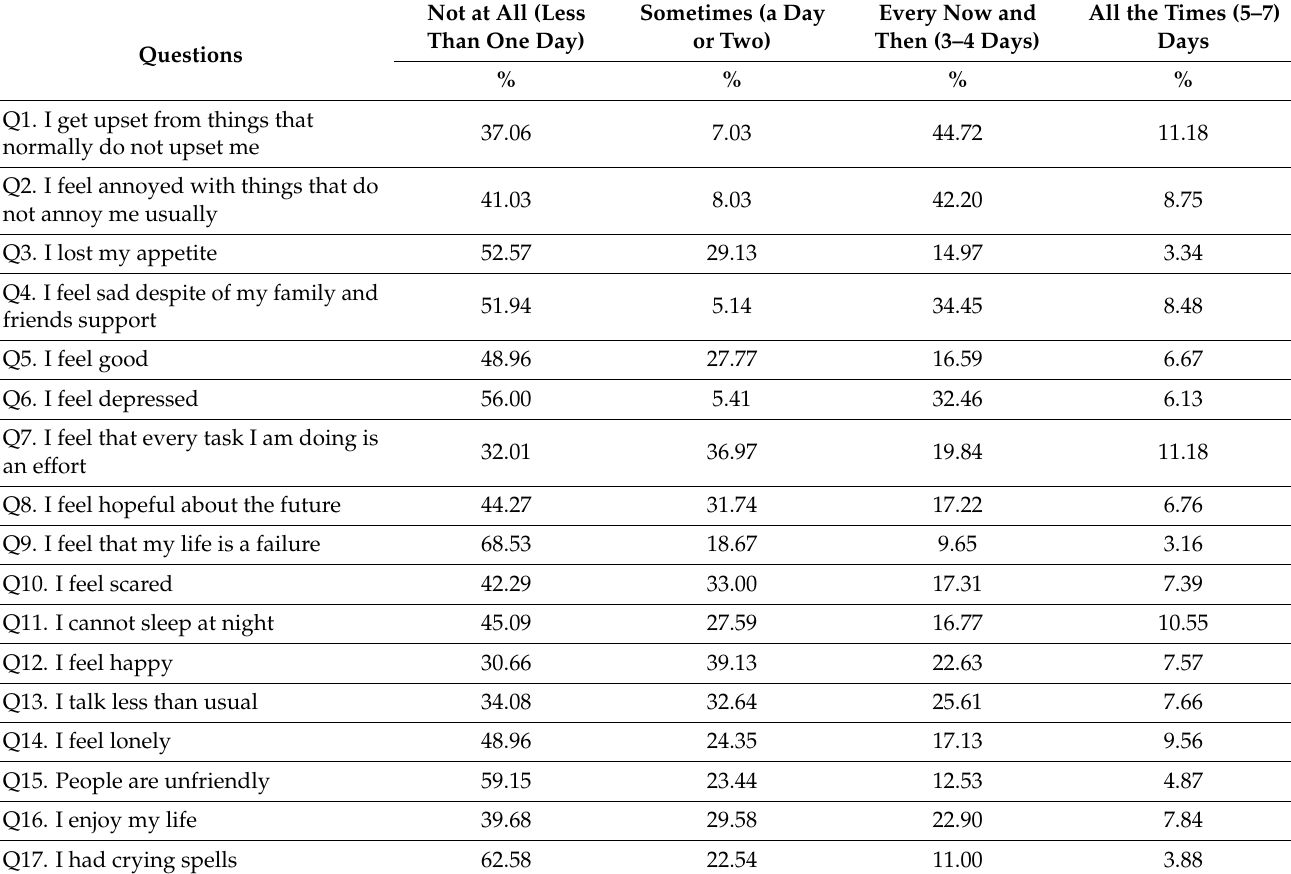
Table 3. Percentage of participants feeling different depression symptoms. Response alternatives: 1 = not at all (less than in one day a week); 2 = sometimes (in one or two days); 3 = every now and then (3–4 days), 4 = all the time (5–7